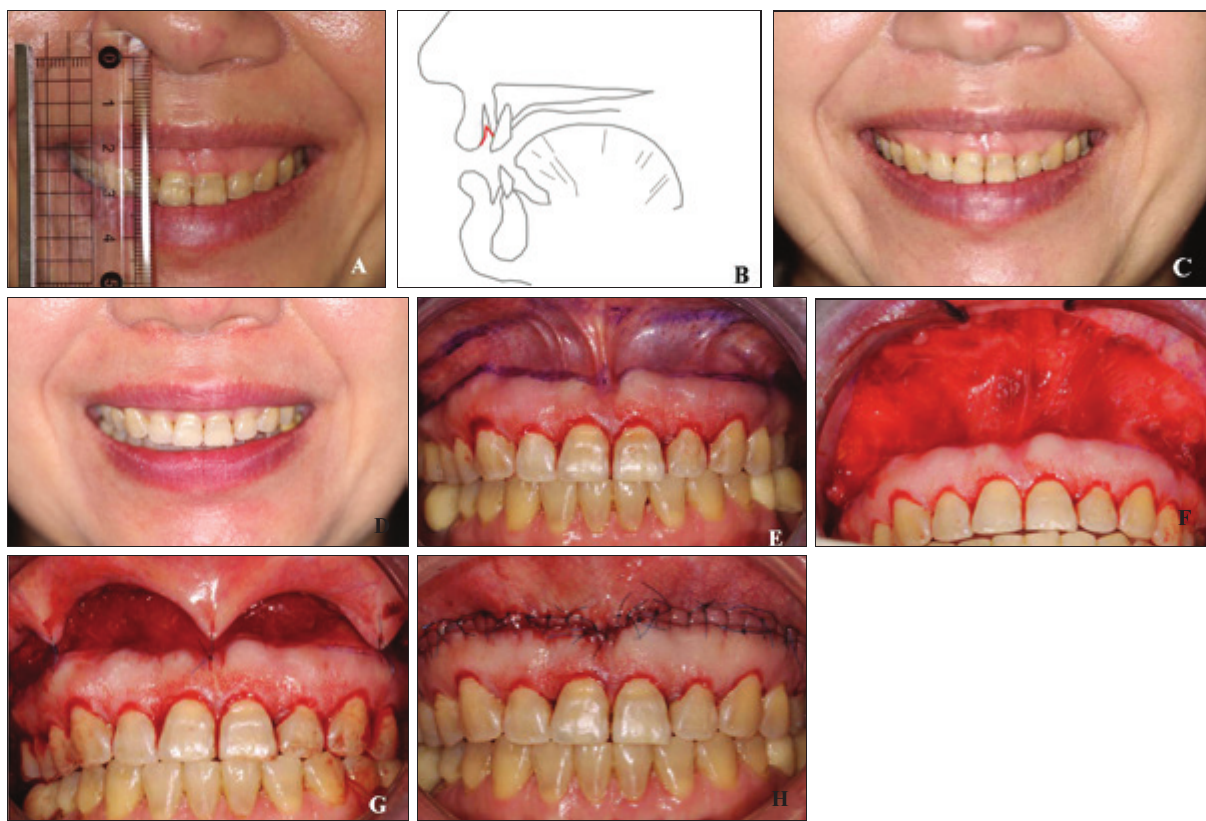
D F Figure 3. (A, C) The patient presented with a chief complaint of excessive gingival display. Lip length is measured from the subnasale to the inferior border of the upper lip. The mobility of the upper lip can be determined by assessing the difference in the upper lip length between the smile at rest and full smile. She was diagnosed with hypermobility of the upper lip and decided to receive a lip repositioning procedure. (B) The purpose of lip repositioning is to limit the labial retraction of the elevator smile muscles in order to reduce gingival display by means of shortening the vestibular depth. (E, F) The amount of excised alveolar mucosa should double the amount of gingival display, which can be marked with colour transfer applicators. (G, H) A partial thickness flap procedure was performed to remove the mucosa tissue, and suturing was performed from the midline and halfway between the two sutures. (D) Great reduction of excessive gingival display was noted after lip repositioning. The thickness of the upper lip increased. Stable results still remained after the one-year visit.